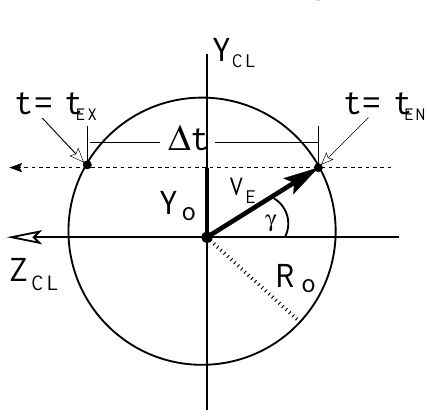
Fig. 3. The cross-section of an ideal MC (circular for convenience) where the spacecraft passes at a closest approach distance Y O from the axis, where t = t EN is the entrance time and t = t EX is the exit time; these times are separated by 1t = T , the “duration” of time that the spacecraft spends inside the MC. V E is the expansion velocity perpendicular to the MC’s axis and shown for the entrance time, t EN . The magnitude of V E ideally holds for all γ